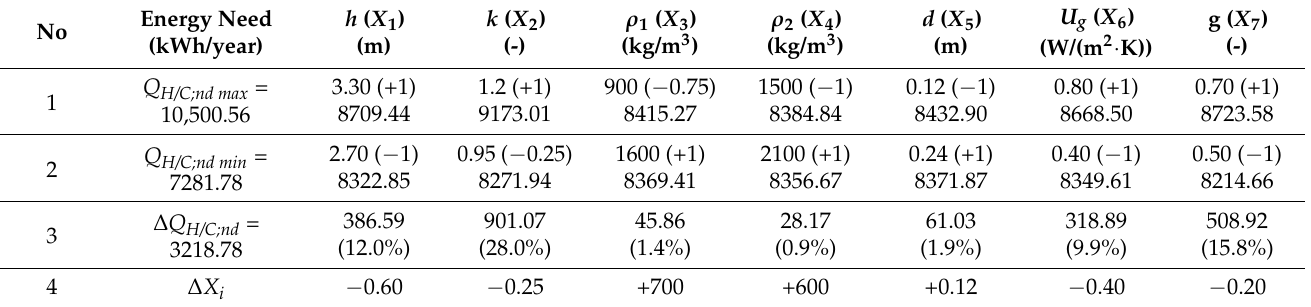
Table 4. Optimal values of the parameters of the selected building with optimization in relation to the energy